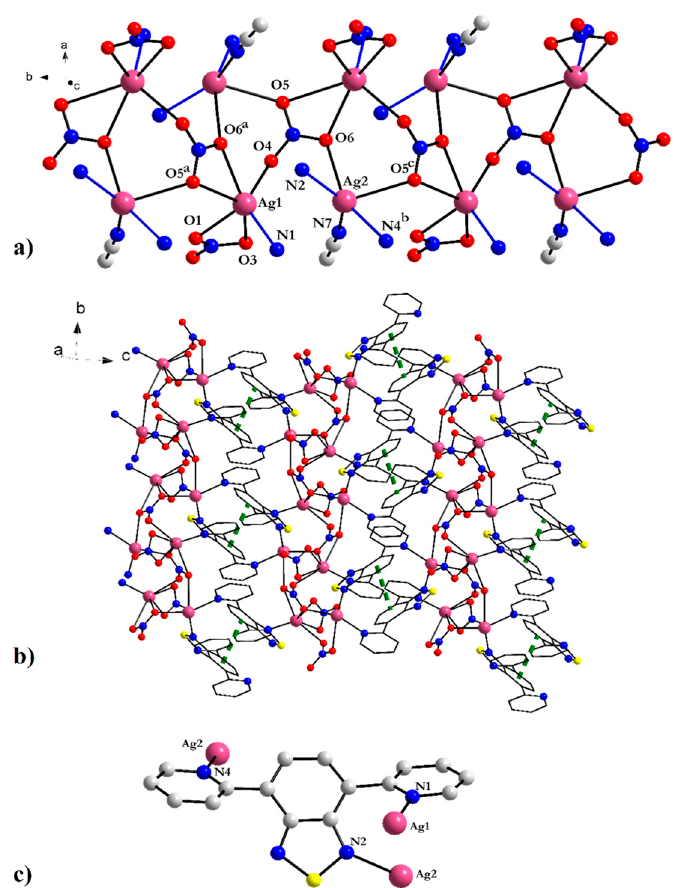
Figure 4. ( a ) Structural detail of a double chain formed by Ag(I) and nitrate ions in the crystal structure of compound 5 . Symmetry operations a = 1 − x , 0.5 + y , 0.5 − z ; b = 1 − x , 1 − y , 1 − z ; c = 1 − x , − 0.5 + y , 0.5 − z ; ( b ) 2D layer resulting from the cross-linking of double chains with 2-PyBTD ligands; ( c ) Tridentate coordination mode adopted by 2-PyBTD in 5